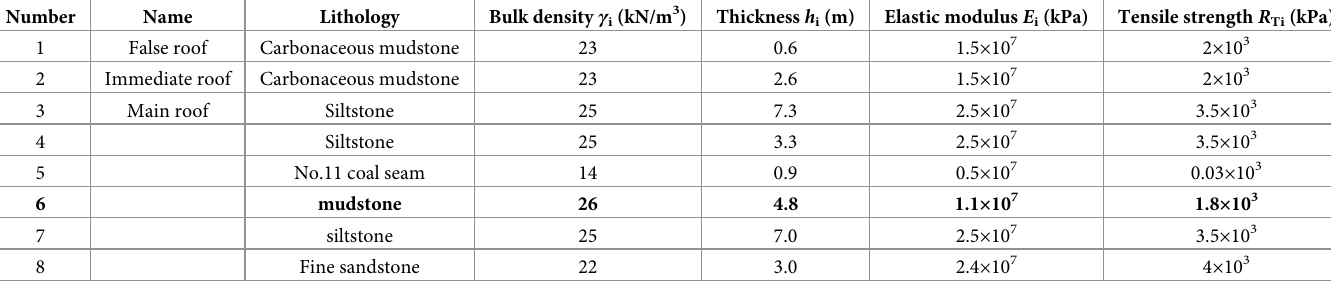
Table 7. Physical and mechanical parameters of roof strata above No.12 -1 coal seam.